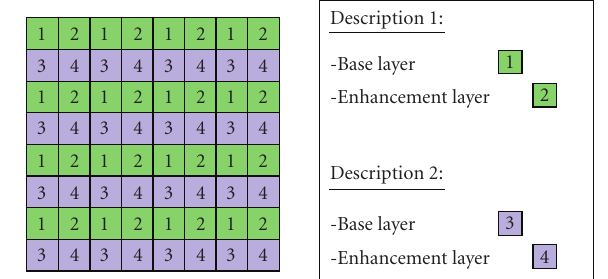
Figure 1: Subsampling patterns and descriptions composition for the case of by rows sampling.